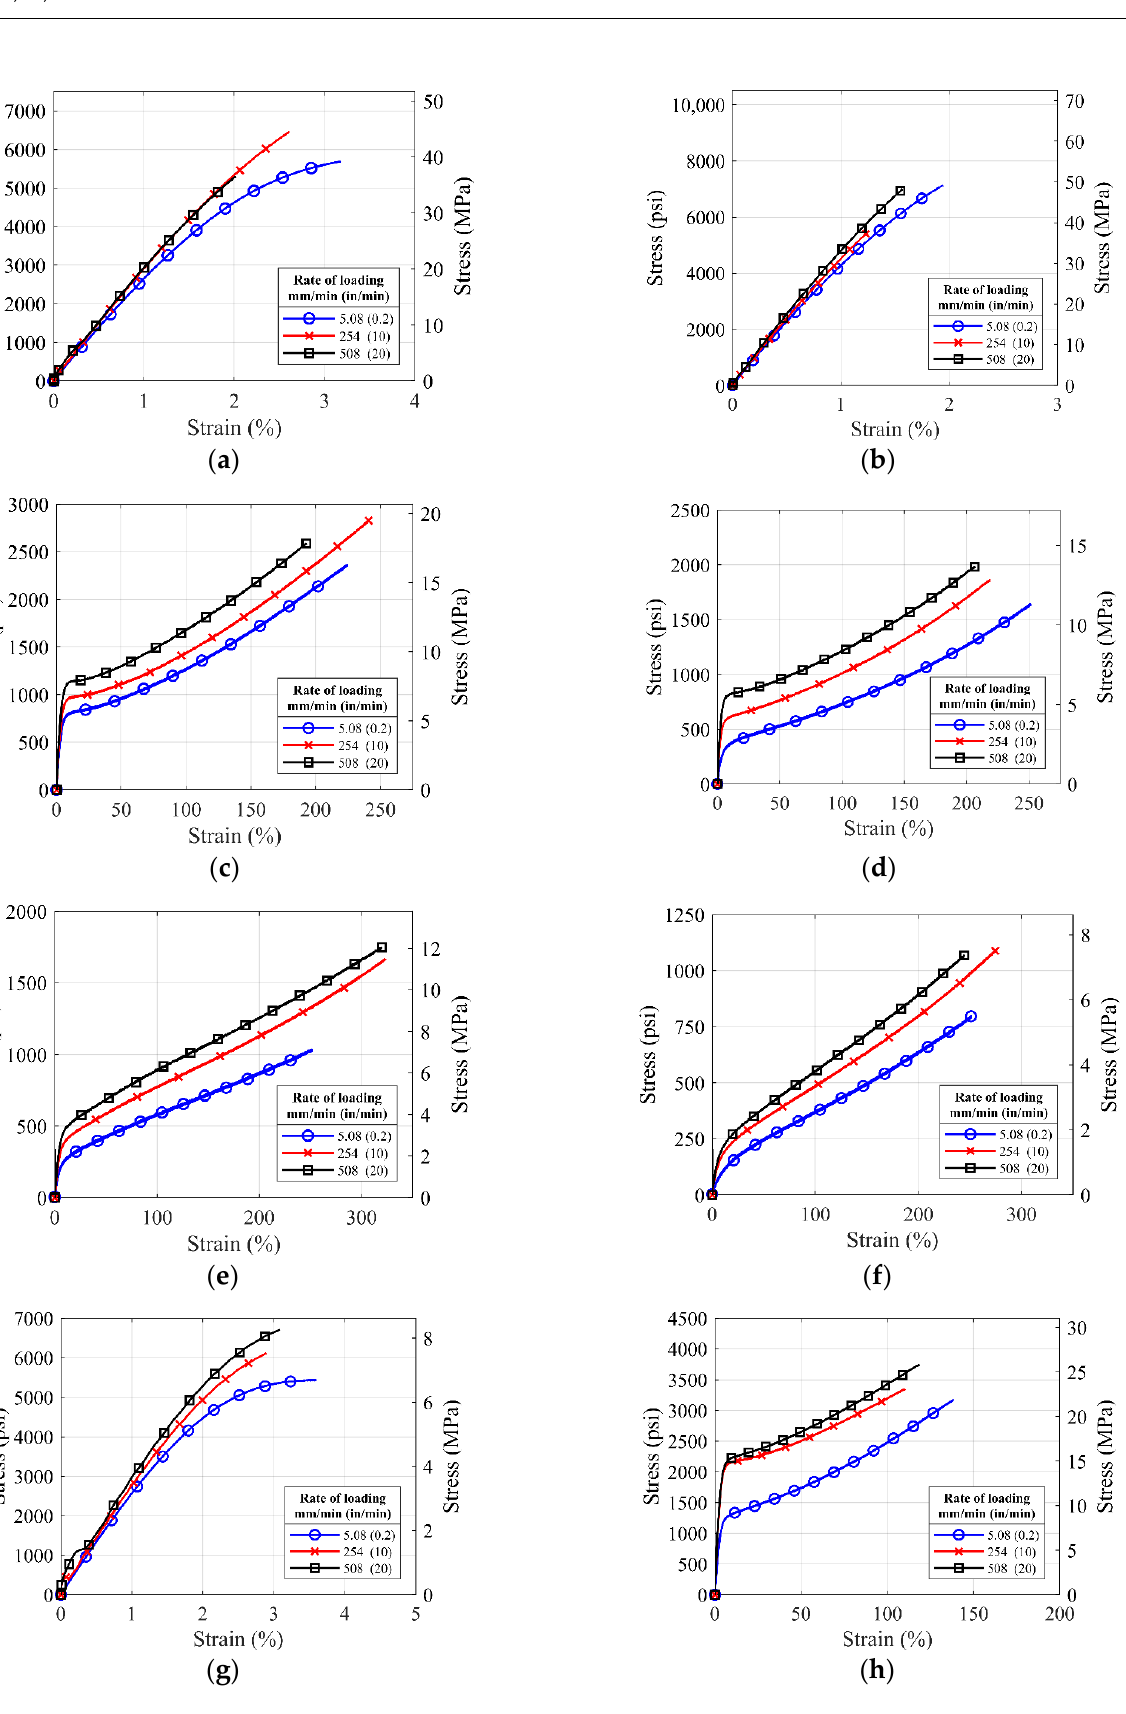
Figure 7. Average stress-strain curves for ASTM die type I coupons of ( a ) S1, ( b ) S2, ( c ) S3, ( d ) S4, ( e ) S5, ( f ) S6, ( g ) S7, and ( h ) S8 material tested with loading rates of 0.2 in/min, 10 in/min and 20 in/min.